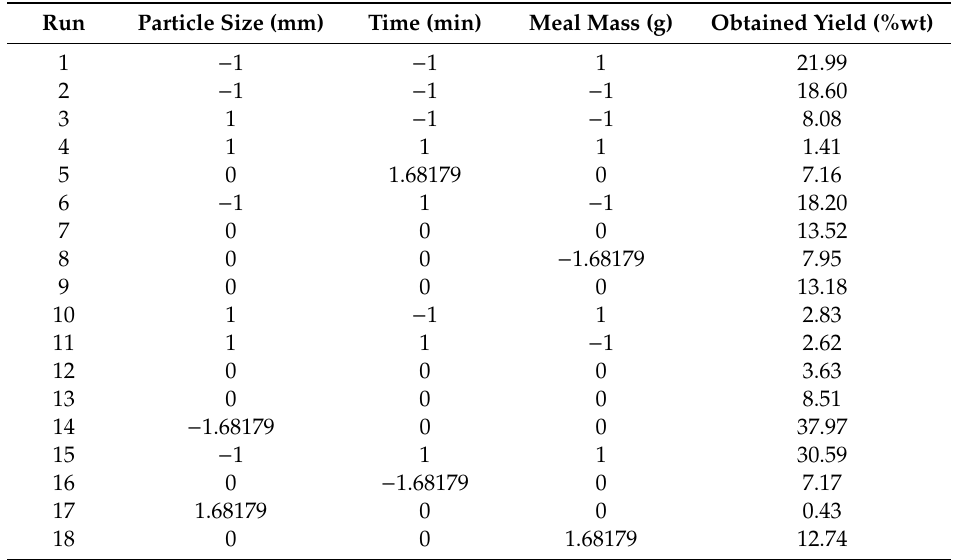
Table 4. Results for the screening experiment excluding reaction temperature from the sources of